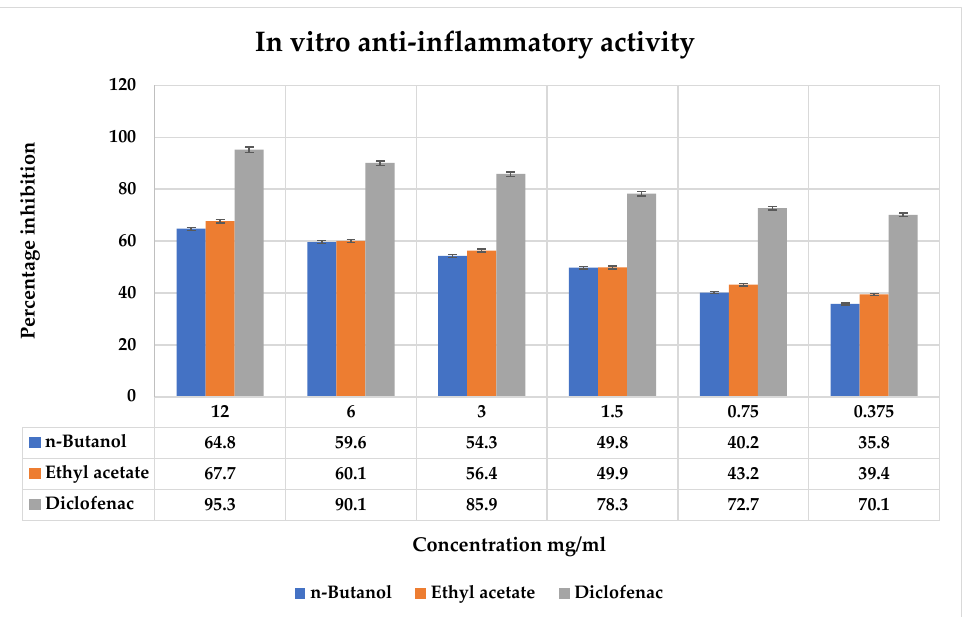
Figure 6. Anti-inflammatory activity of ethyl acetate and n -butanol fractions of T. vulgaris compared with the standard diclofenac. For each parameter, the vertical bar represents the mean ± S.E . The values were expressed in the mean ± SD of triplicates, and all values were statistically significant at p < 0.05.